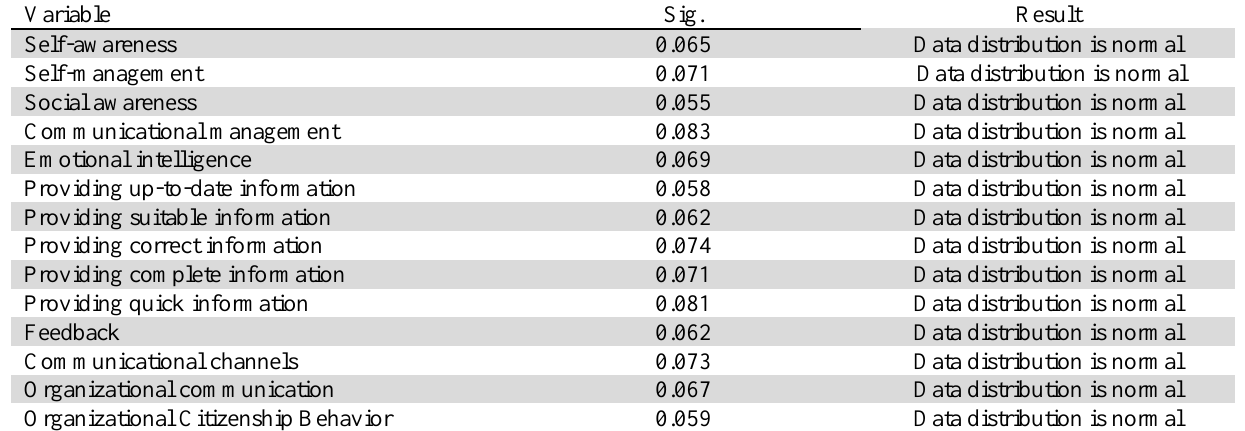
The summary of Kolmogorov-Smirnov test